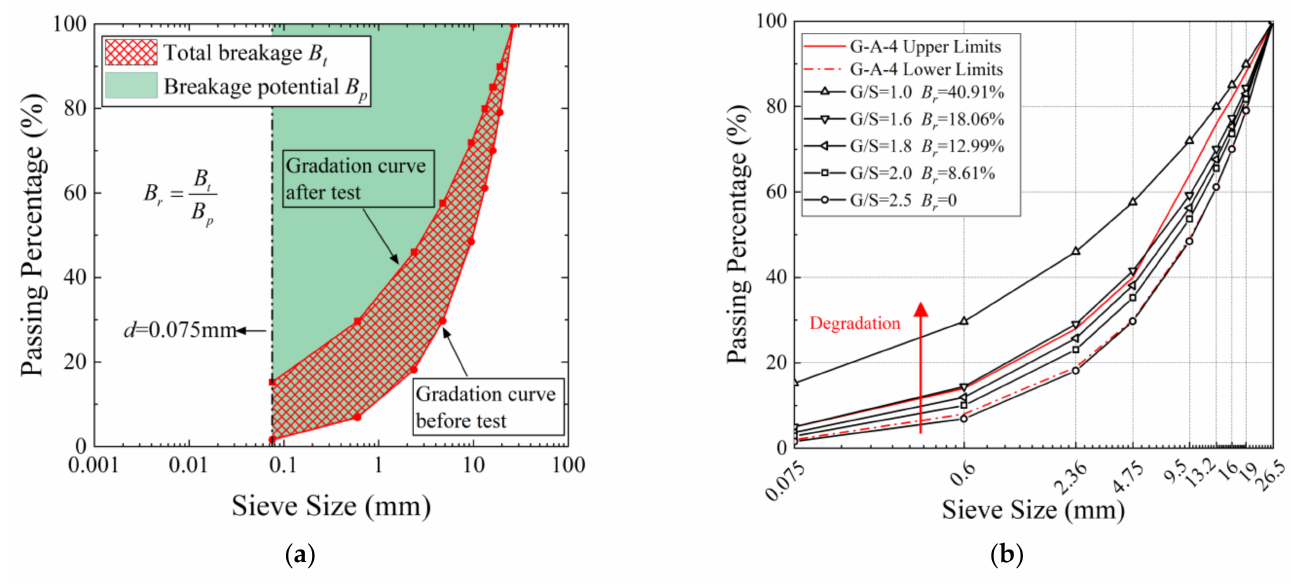
Figure 4. Gradation curves of recycled BDW aggregates representing particle-breakage-induced gradation variations. ( a ) Definition of particle breakage index B r . ( b ) Gradation curves and their corresponding B r